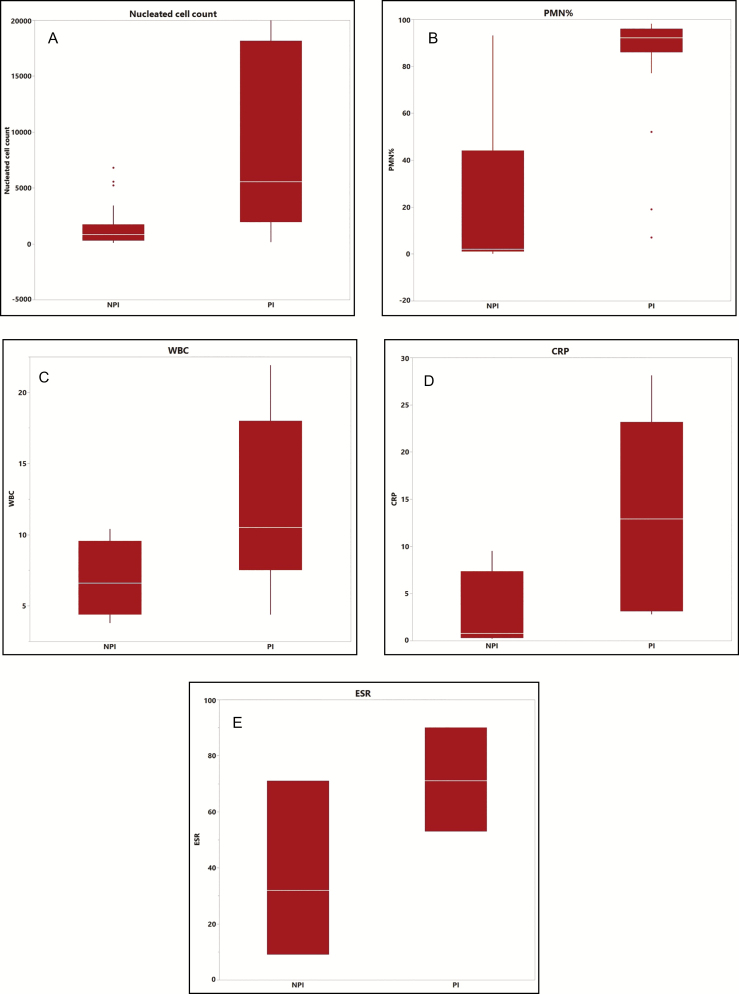
Box plots of periprosthetic fluid cell count and differential vs plasma levels of traditional inflammatory markers. PI, Periprosthetic Infection; NPI, No periprosthetic infection. (A) Total nucleated cell count. (B) Percentage of polymorphonuclear neutrophils, PMN%. (C) White blood cell count, WBC. (D) C-reactive protein, CRP. (E) Erythrocyte sedimentation rate, ESR. Note the greater separation of the 2 groups with fluid analysis markers compared with traditional inflammatory markers.